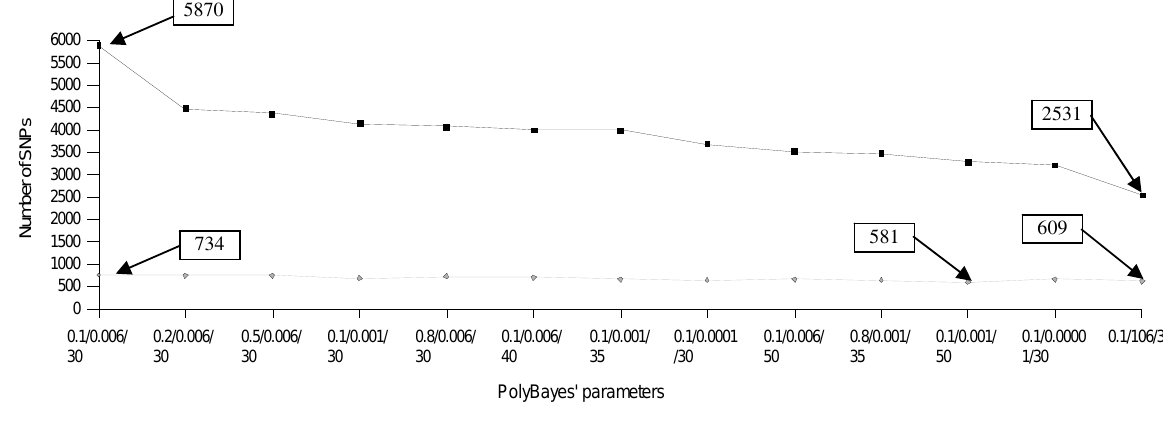
Fig 1: Number of detected SNPs given PolyBayes sets of parameters. Number of SNPs detected by PolyBayes. Number of redundant SNPs detected by